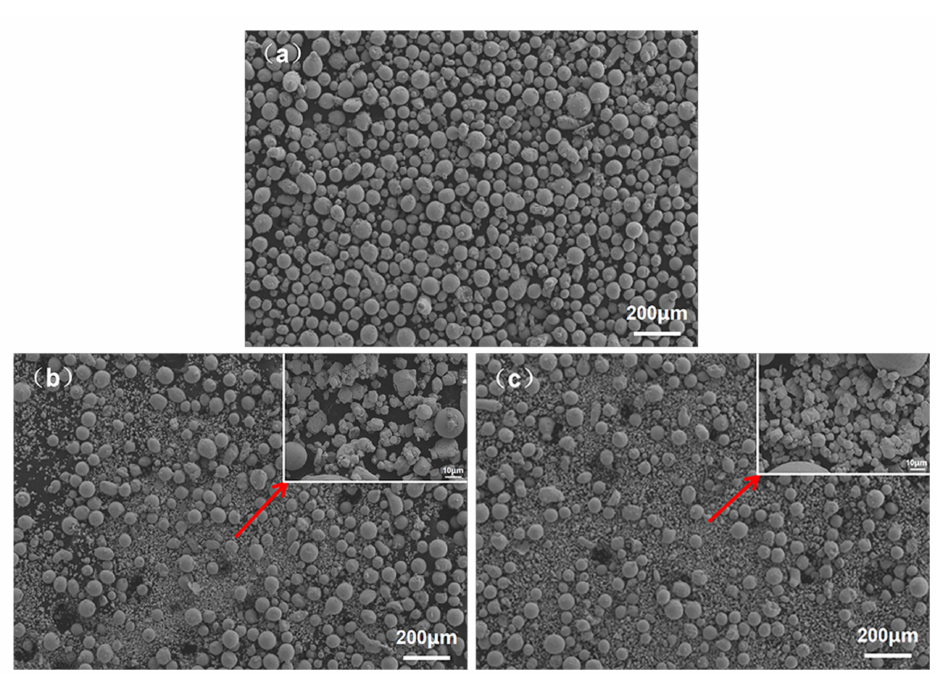
Figure 1. FESEEM images of the AlCoCrFeNiW x HEA powder: ( a ) x = 0, ( b ) x = 0.5, ( c ) x = 1. Table 1. The chemical composition of AlCoCrFeNi HEA powder.